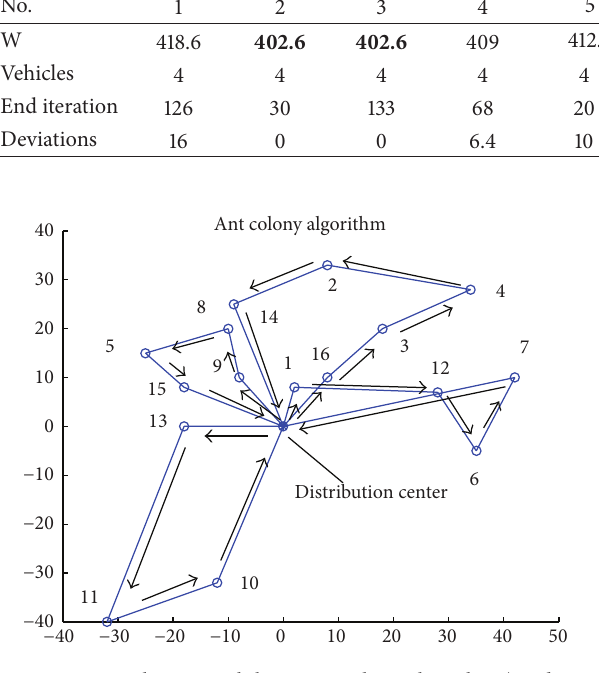
Figure 9: Distribution path DNA-ant colony algorithm (moderate or high level pollution).